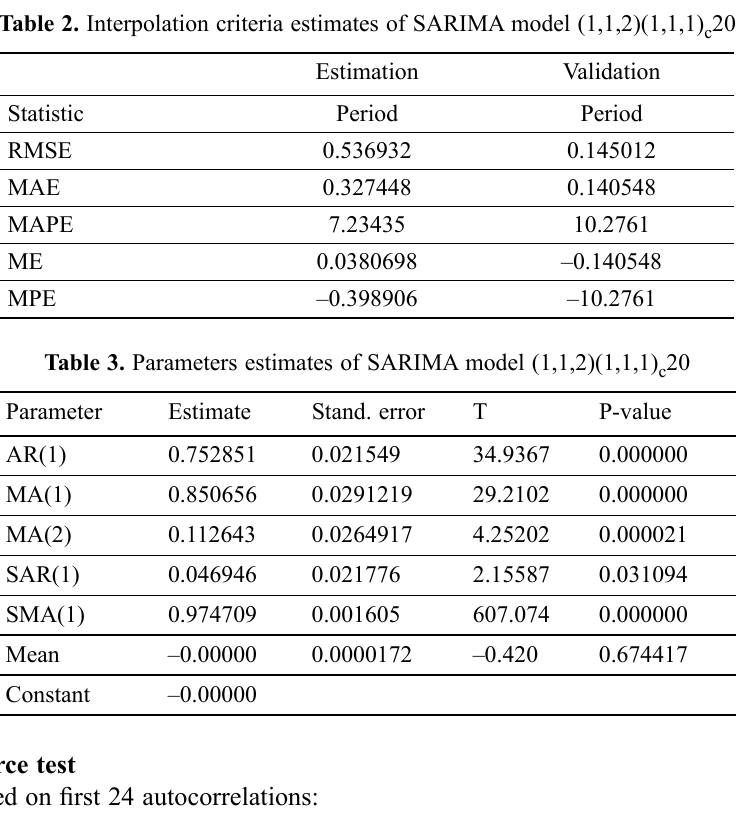
Table 2. Interpolation criteria estimates of SARIMA model (1,1,2)(1,1,1)